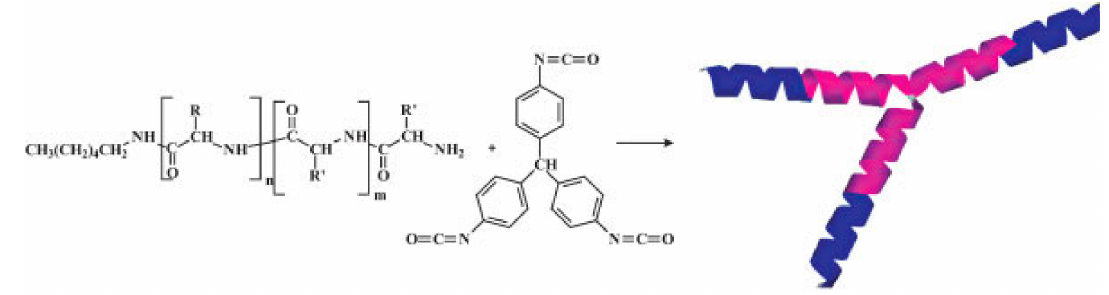
Figure 43. Strategy reported by Aliferis et al. used to fabricate three-arm polypeptides by the arm-first strategy. Reproduced with permission from reference [201].